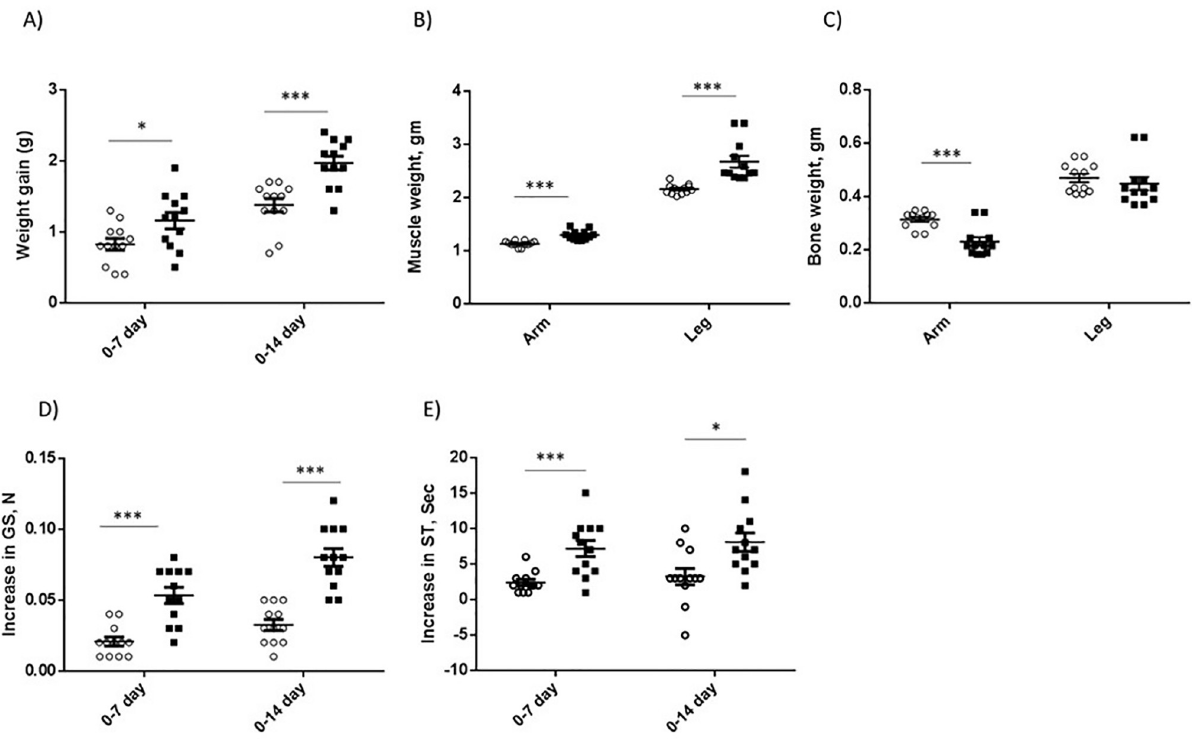
Fig 7. Effects of Pep45-65-NH2 on body wt gain (A), muscle wt (B), bone mass (C), increase in grip strength (D), and increase in swimming time (E). Open circle ( � ) and closed square ( ■ ) indicate 0 and 20 mg/kg body wt administration of Pep-45-65-NH2. Student‘s t -test was used to compare the mean difference. +, P < 0.1; � , P < 0.05; �� , P < 0.01; ��� . P < 0.001.